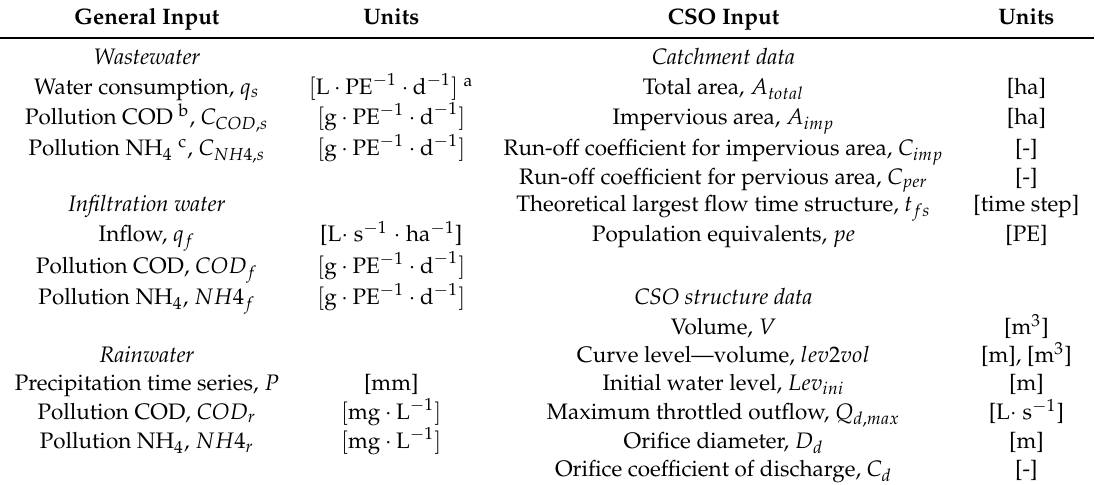
Table 1. General input data and combined sewer overflow (CSO) data to be defined by the input object.